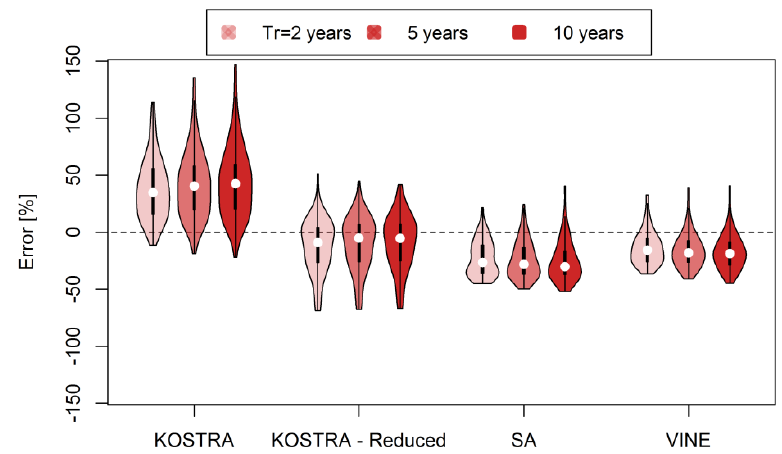
Figure 10. Comparison of models regarding their ability to reproduce extreme events for durations ranging from 5 min to 24 h for all stations. Water 2018 , 10 , x FOR PEER REVIEW